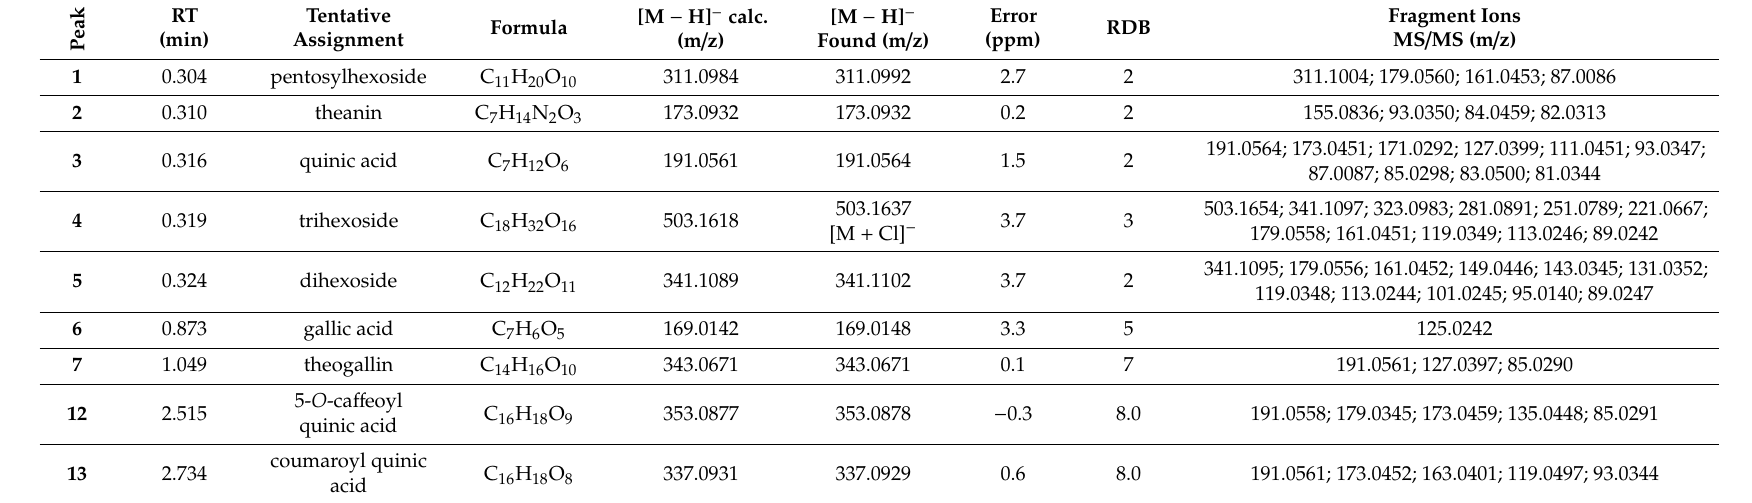
Table 1. TOF-MS and TOF-MS / MS of tentatively identified non-flavonoid compounds in investigated green tea extracts. Compounds are numbered based on their RT in the whole total ion current chromatogram. RT = Retention Time; RDB = Ring Double Bond equivalent